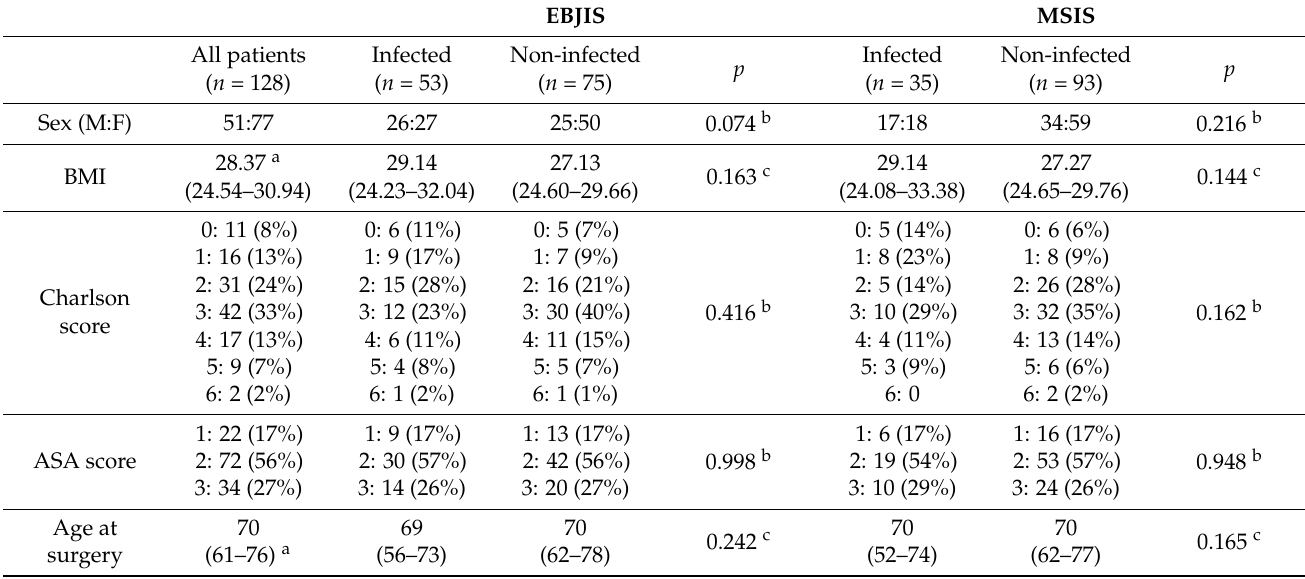
Figure 1. Flow-chart of the patients included in the study. Table 2. Demographics of the study